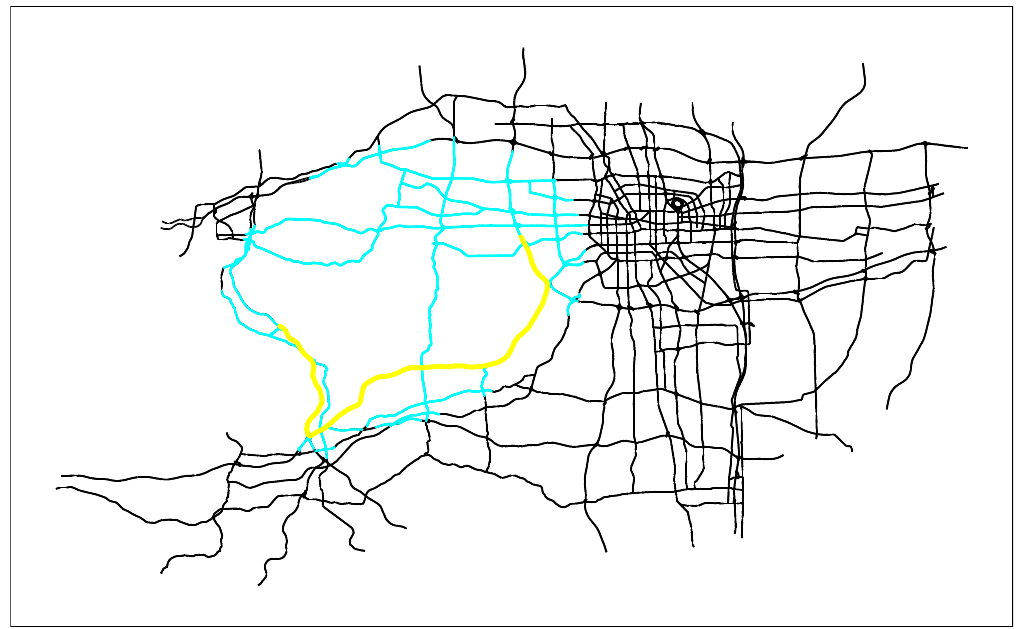
Figure 7. The search results of the shortest path algorithm based on the dynamic ellipse limit search area of the virtual boundary under the 95% confidence level.